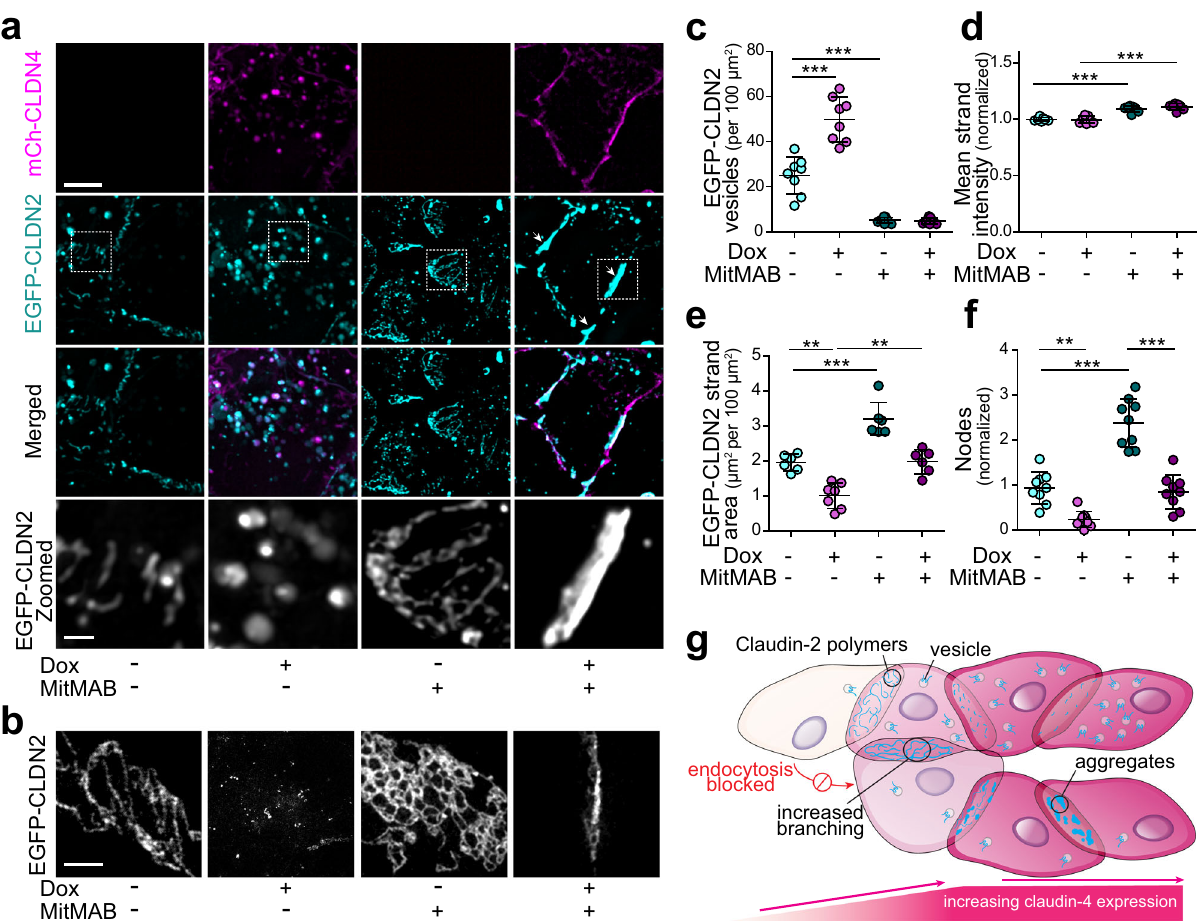
Fig. 7 Endocytic blockade is insuf fi cient to preserve claudin-2 strand structure. a Dynamin inhibition with MitMAB blocks EGFP-claudin-2 (cyan) endocytosis but does not prevent strand collapse after mCherry-claudin-4 (magenta) expression in U2OS cells. In the absence of claudin-4, dynamin inhibition increases the complexity of EGFP-claudin-2 strand networks. Maximum projection images representative of 4 independent experiments. Scale: 5 µ m, 1 µ m. b STED images show EGFP-claudin-2 in the presence of MitMAB or mCherry-claudin-4, either individually or in combination. Representative of at least 4 independent experiments. Scale: 2 µ m. c mCherry-claudin-4 (magenta) expression increases EGFP-claudin-2 (cyan) vesicle numbers compared to EGFP-claudin-2 in the absence of claudin-4 expression. Dynamin inhibition using 10 µ M MitMAB (dark symbols) reduces claudin-2 vesicle numbers in the presence or absence of claudin-4. n = 8 – 9, representative of 5 independent experiments. 1-way ANOVA. *** P < 0.0001. d Fluorescence intensity of EGFP-claudin-2 meshworks is signi fi cantly increased by dynamin inhibition. n = 7, representative of 5 independent experiments. *** P < 0.0001. e Dynamin inhibition increases strand area in the absence of claudin-4 expression. mCherry-claudin-4 induces collapse and reduces the area covered by